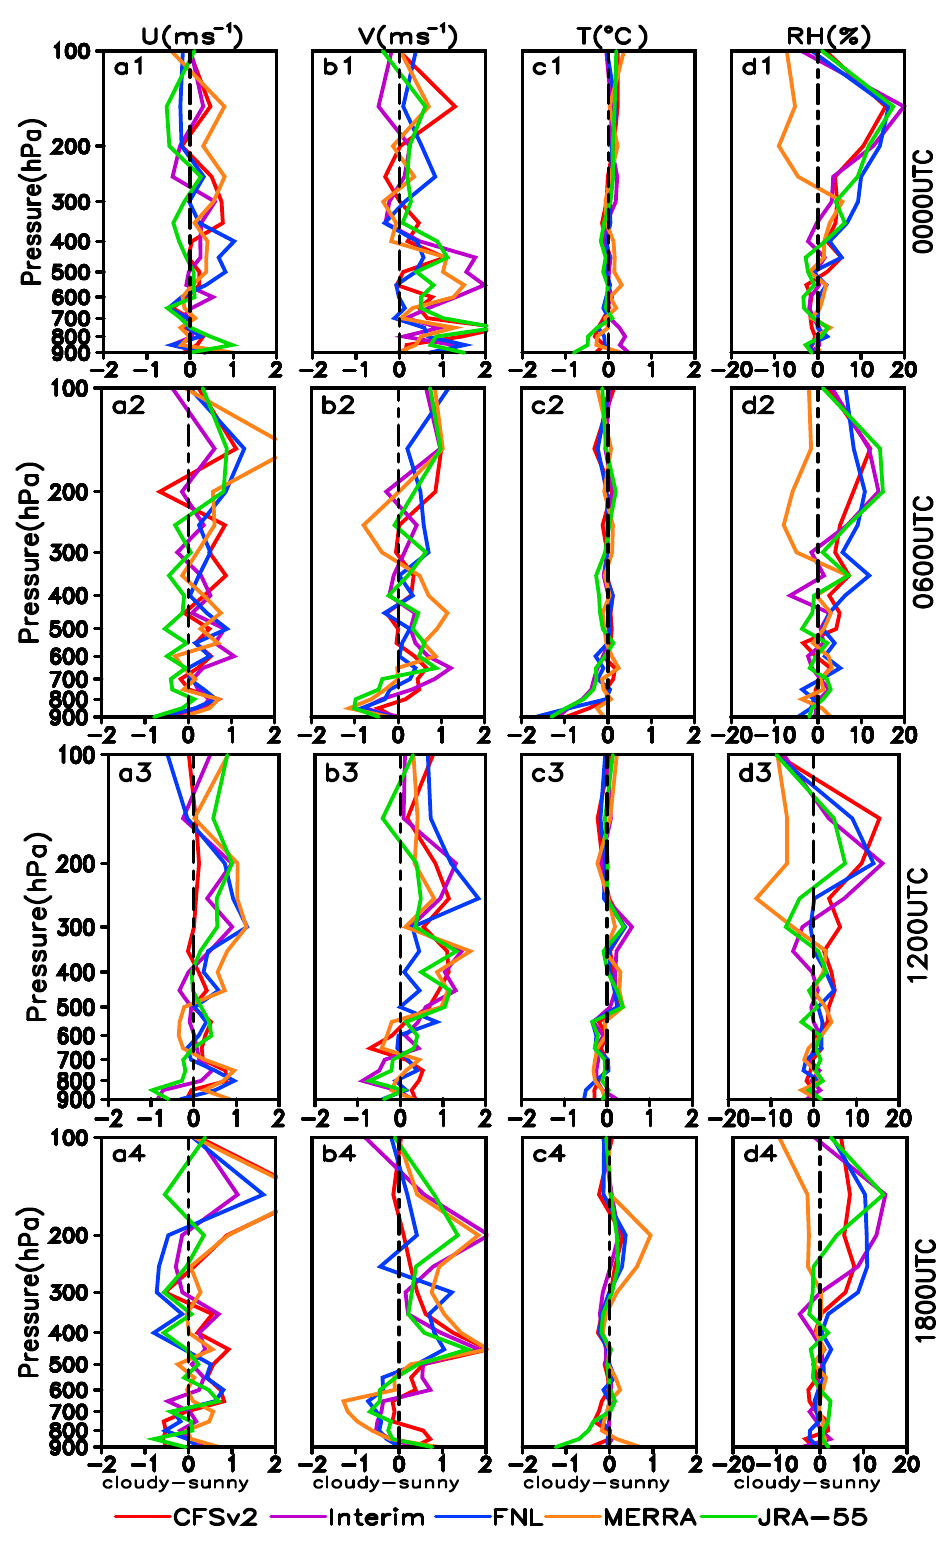
Figure 6. The difference of absolute values of the mean bias of U ( a1 – a4 ), V ( b1 – b4 ), T ( c1 – c4 ), and RH ( d1 – d4 ) between those occurring on cloudy days and on sunny days in the GDs against the radiosonde data, averaged over sounding five sites in the